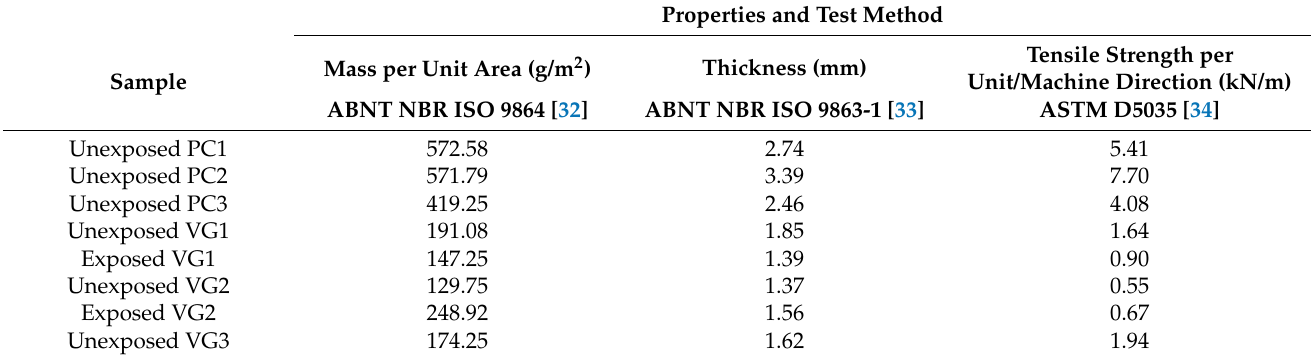
Table 3. Physical and mechanical characteristics of the exhumed